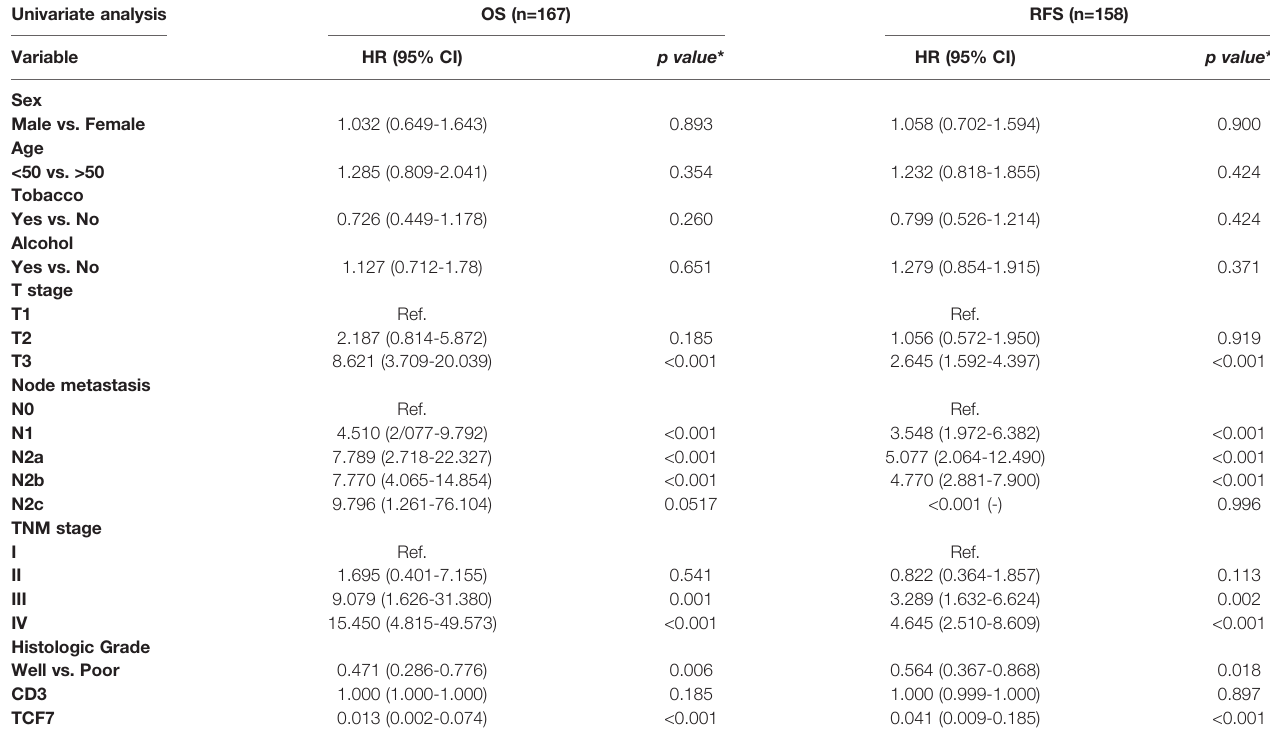
TABLE 2 | Univariate analysis of factors associated with overall survival. Univariate analysis